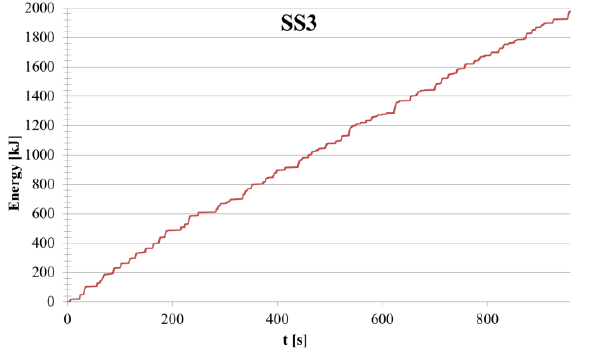
Fig. 6. Braking energy and vehicle speed during SS3